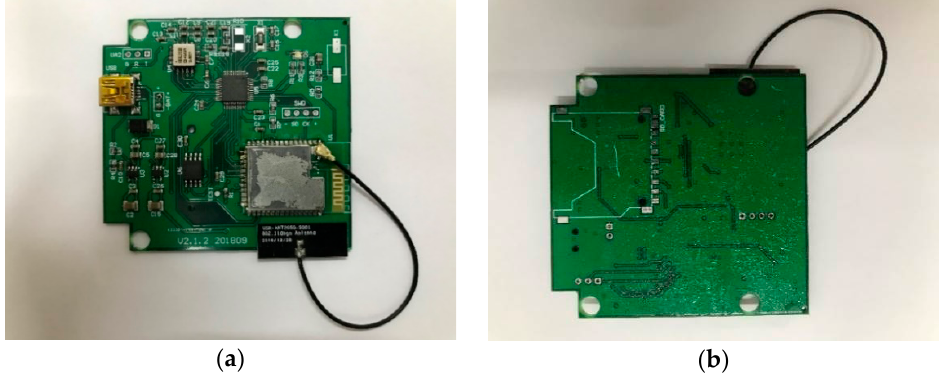
Figure 8. The ADXL355-based MEMS inclinometer. ( a ) The top side; ( b ) the bottom side. Table 2. The specifications of the ADXL355 MEMS accelerometer.